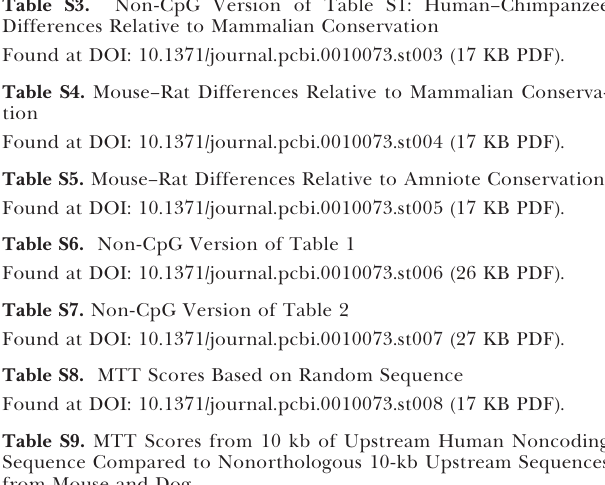
Figure S3. Calculating an MTT for the Window on Top (e.g., from Human) against Two Longer Sequences (e.g., from Mouse and Dog) Consider all possible combinations of three 16-bp windows where one window comes from each species. Here we highlight two such combinations in red and blue. For each combination we consider the three pairwise comparisons and take the minimum similarity score. For the window combinations indicated in red, this is 12, and for the combinations indicated in blue, it is 10. We then find the combination (or combinations) of three windows that has the largest minimum similarity score. This score is the MTT. Here the MTT for the window on top is 12. Note that we also consider all the combinations of reverse complements. Figure S4. Plots of the Probability of MTT Scores 14, 15, and 16 as a Function of Position Upstream of the Transcription Start Site This is for human–mouse–dog three-way comparisons. In this plot, the probability is averaged over 50-bp regions. Conservation increases significantly near to the gene; 26.7% of all 16 scores, 23.9% of all 15 scores, and 19.7% of all 14 scores occur within 500 bp of the transcription start site. Figure S5. A Section of Aligned Sequence (Made Up for Illustrative Purposes) We have already taken human upstream sequence and calculated MTT conservation scores for every 16-bp window. We now take all windows with a particular score and find them in the alignment. Imagine for example that the three windows we have highlighted in blue represent all the windows with a 13 score. We examine the positions adjacent to these, here highlighted in red, and count the number of nucleotides that are the same or different. For our windows with a 13 score, four are the same and two are different. We repeat this for the other possible window scores, creating a table such as Table S1. Table S1. Human–Chimpanzee Differences Relative to Mammalian Conservation Table S2. Human–Chimpanzee Differences Relative to Amniote Conservation Table S3. Non-CpG Version of Table S1: Human–Chimpanzee Differences Relative to Mammalian Conservation Table S4. Mouse–Rat Differences Relative to Mammalian Conserva- tion Table S5. Mouse–Rat Differences Relative to Amniote Conservation Table S6. Non-CpG Version of Table 1 Table S7. Non-CpG Version of Table 2 Table S8. MTT Scores Based on Random Sequence Table S9. MTT Scores from 10 kb of Upstream Human Noncoding Sequence Compared to Nonorthologous 10-kb Upstream Sequences from Mouse and